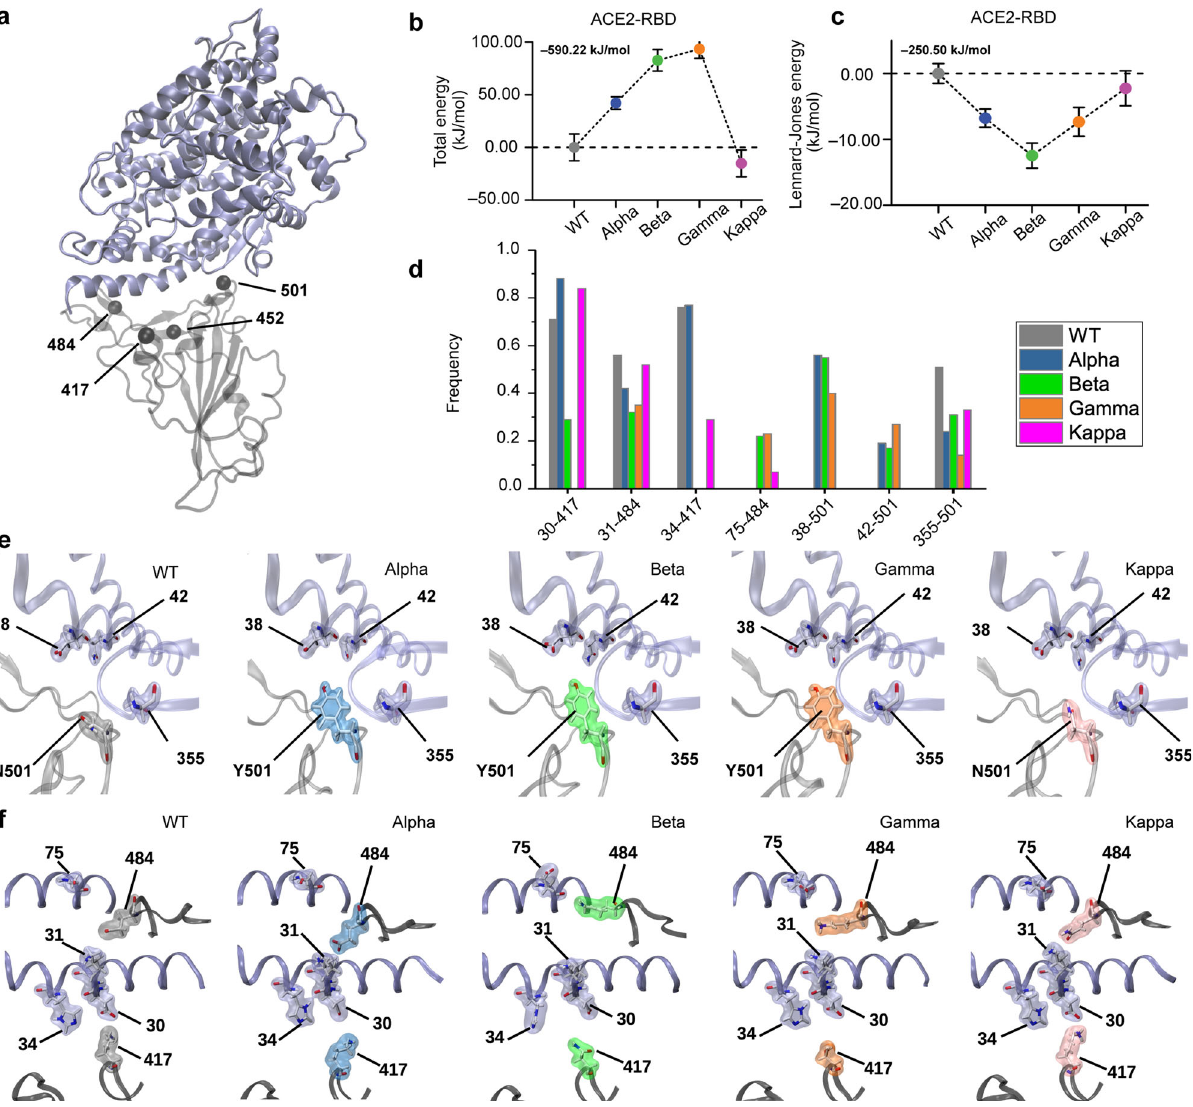
Fig. 3 MD simulation of the RBD — ACE2 of WT and VoCs. a Ribbon-like representation of the RBD — ACE2 complex and highlight of residues mutated in VoCs. b Total energies and c Lennard − Jones energies for all RBD — ACE2 complexes. d Average frequencies of contacts from 7.5 μ s of MD trajectory of SARS-CoV-2 WT (gray) and VoCs Alpha (blue), Beta (green), Gamma (orange), and Kappa (purple). High-frequency contacts are shown in the form (ACE2 residue number) — (RBD residue number) for seven contacts involving relevant mutations. Zoom-in on the RBD — ACE2 region around e RBD residue 501 and f around RBD residues 484 and 417 for the WT and the 4 VoCs. Sidechains are represented by sticks. Residues 38, 42, and 355 in ACE2 contacting RBD residue 501 ( e ) and residues 30, 31, 34, and 75 in ACE2 contacting RBD 417 or 484, respectively, are shown. Data in b , c show the mean and the whiskers are the s.d. of the mean value obtained from N = 3130 (WT), N = 2851 (Alpha), and N = 3130 (Beta and